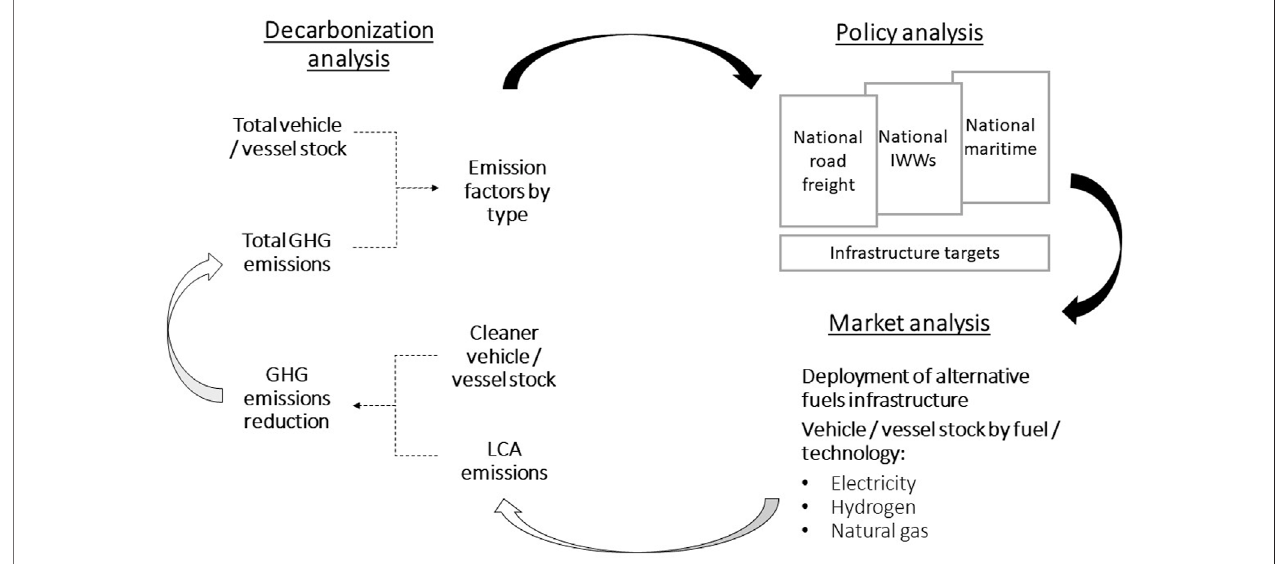
FIGURE 1 | Overview of the three types of analysis conducted within the global process of greening the European transport system. Note: Infrastructure in this paper refers to shore-side electricity and LNG supply for inland waterways vessels and seagoing ships. For the results related to road freight, see Gómez Vilchez et al. (2022). Source: own work.